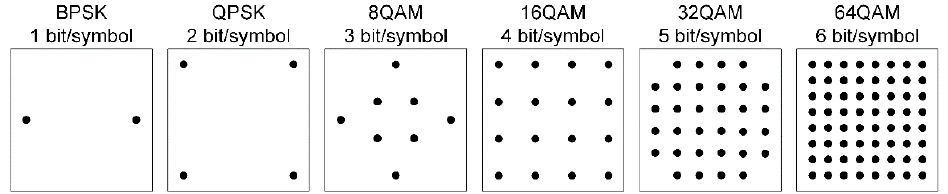
Figure 3. Constellation diagrams of modulation formats used for the bit- and power-loaded DMT signal generation. Binary phase shift keying (BPSK) encodes 1 bit/symbol. Quadrature phase shift keying (QPSK) encodes 2 bit/symbol. The quadrature amplitude modulation (QAM) formats: 8QAM,